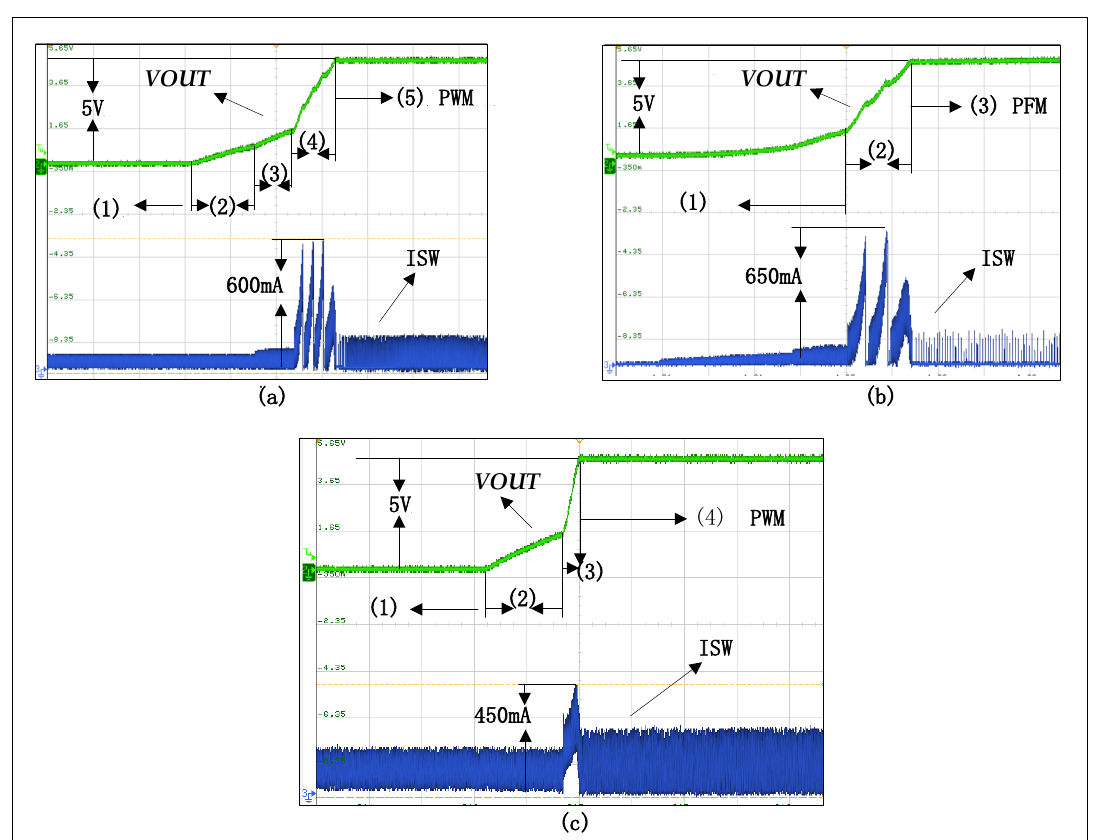
Figure 14. Experimental results of the start-up process of the boost converter. ( a ) When VIN = 0.7 V and ILOAD = 1 mA. ( b ) When VIN = 3.6 V and ILOAD = 50 mA. ( c ) When VIN = 3.6 V and ILOAD = 200